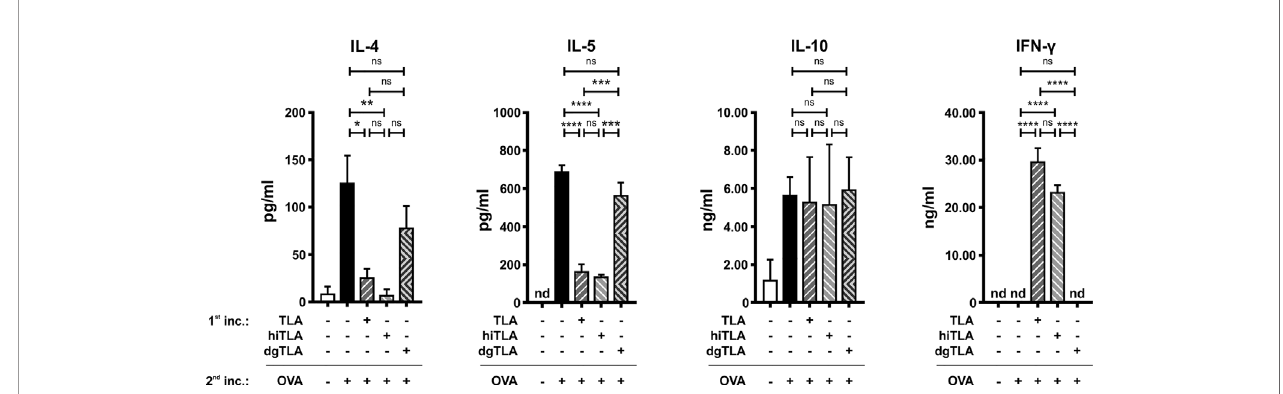
FIGURE 7 | Ex vivo stimulation with TLA and hiTLA, but not dgTLA reduces type 2 cytokines and elevates IFN- g . Levels of IL-4, IL-5, IL-10, and IFN- g after stimulation with medium, TLA, hiTLA or dgTLA, followed by stimulation with medium or ovalbumin (OVA) of splenocytes excised from allergic control mice after sensitization and challenge. Graphs show results from 1 representative experiment from 2 independent experiments with 3 mice per group. Error bars show mean ± SEM. nd not detectable; TLA , tachyzoites lysate antigen; hiTLA , heat-inactivated TLA; dgTLA , deglycosylated TLA; inc , incubation. ns , not signi fi cant; *P < 0.05; **P < 0.01; ***P < 0.001; ****P <